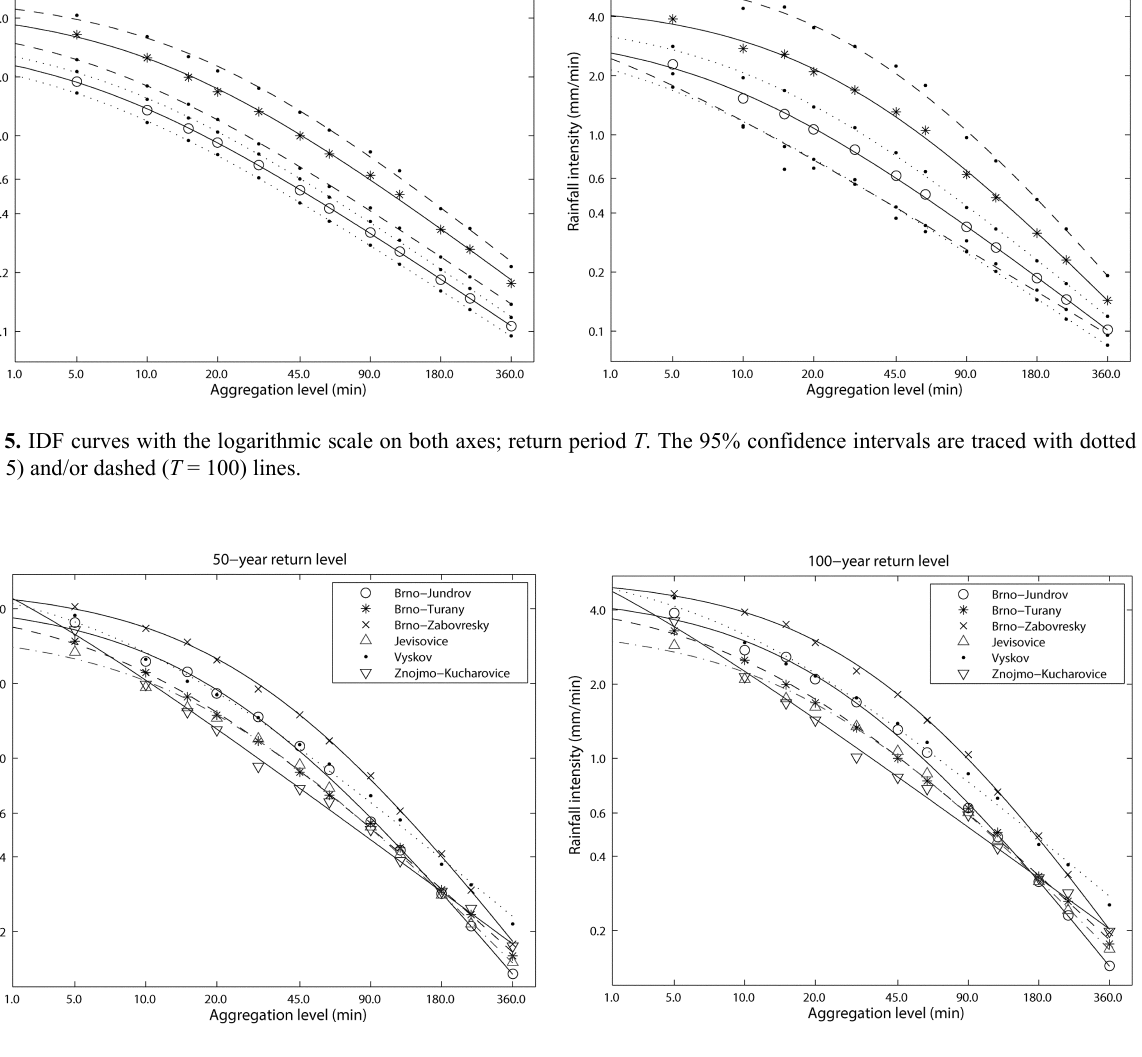
Fig. 6. Comparison of IDF curves for all stations with the logarithmic scale on both axes; return periods T = 50 and T = 100 years.